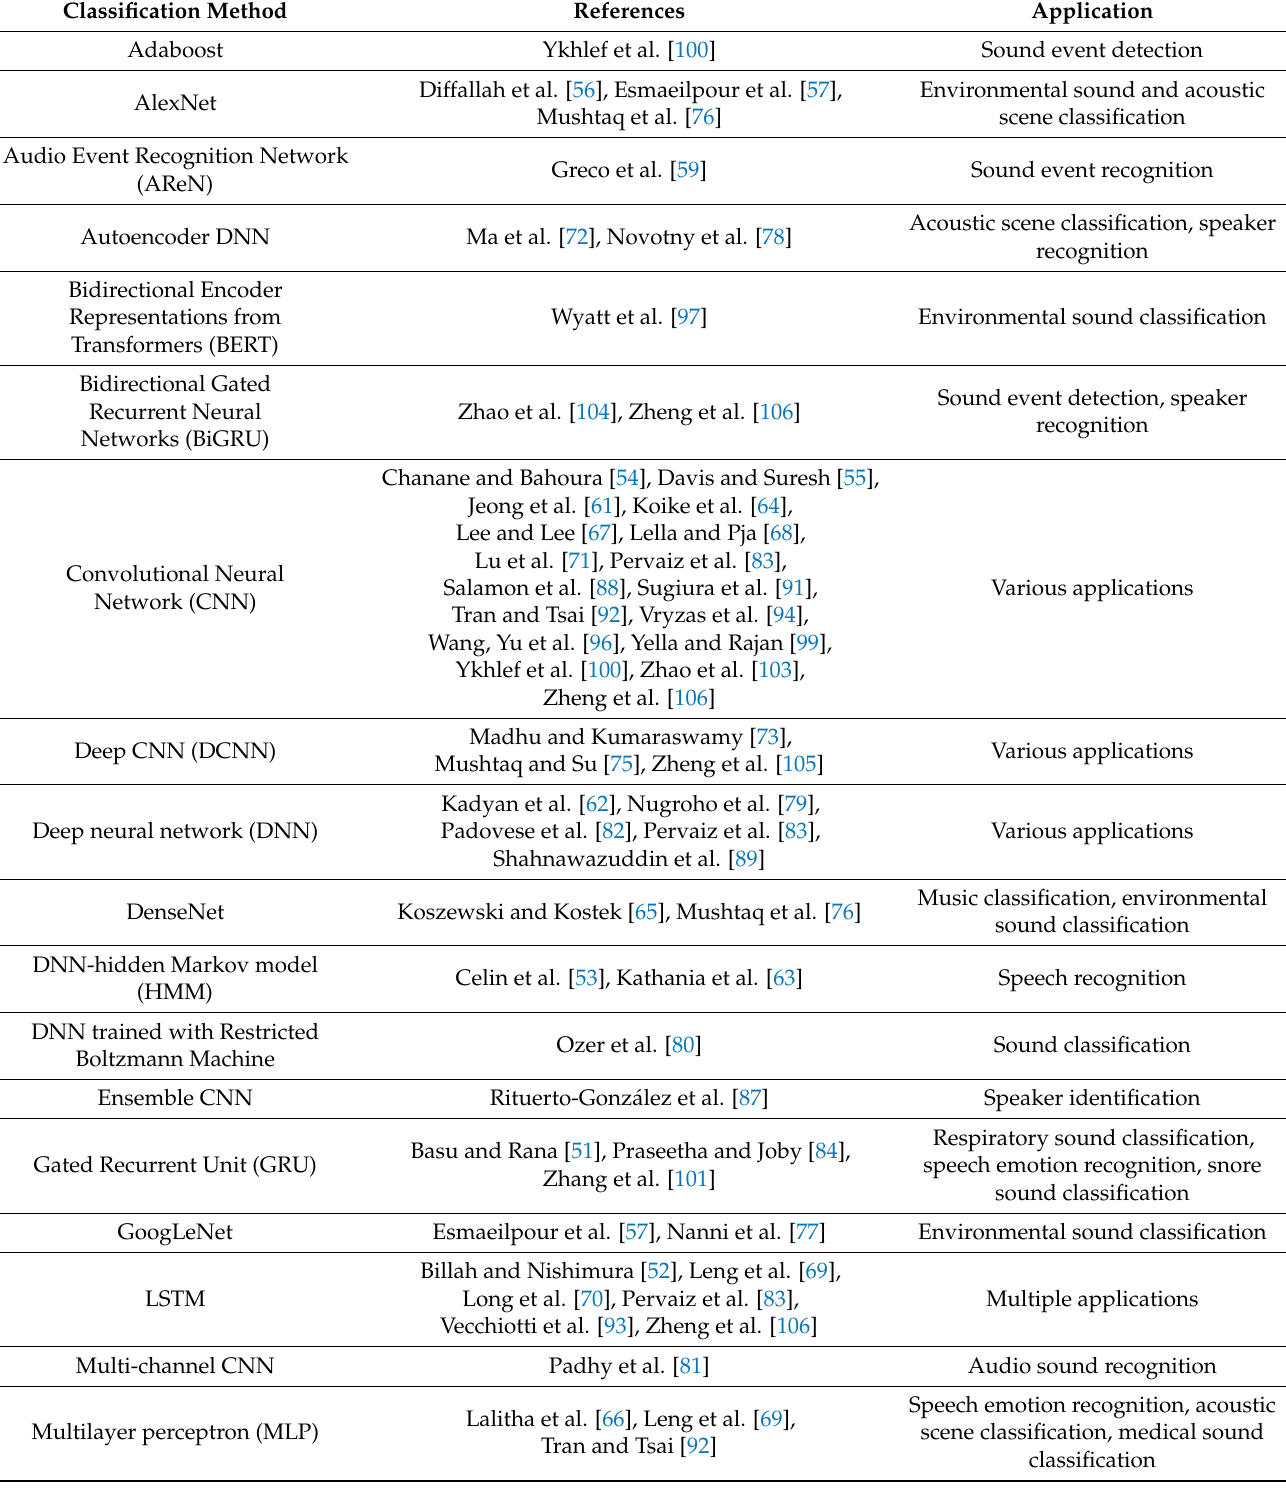
Table 5. Summary of classification